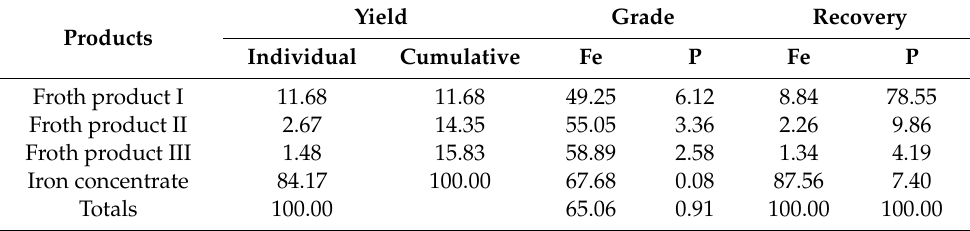
Table 3. E ff ect of scavenging time on iron and phosphorus grades and recoveries in reverse flotation (%).